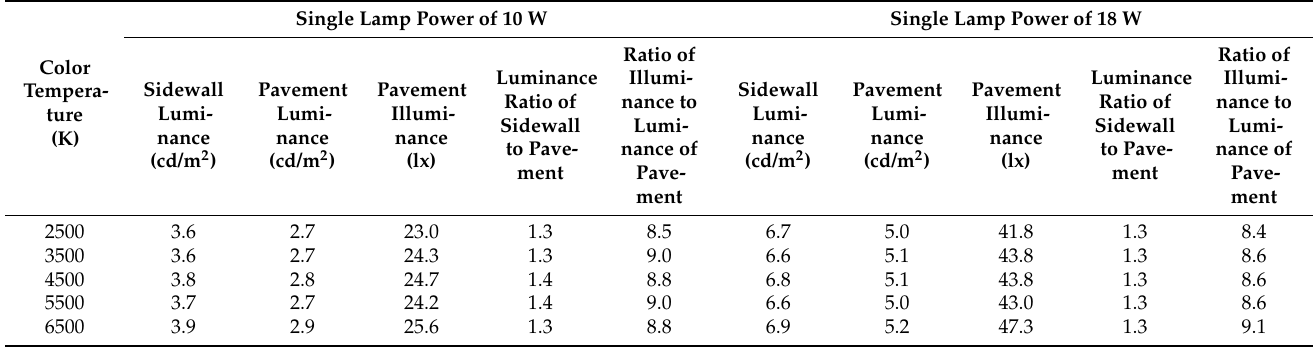
Table 1. Luminance and illuminance in tunnel decorated with energy-storage and luminescent coating.